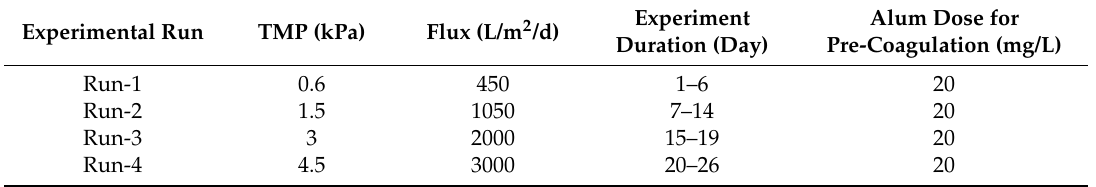
Table 1. The detailed specifications of the filtration experiments. TMP = trans-membrane pressure.